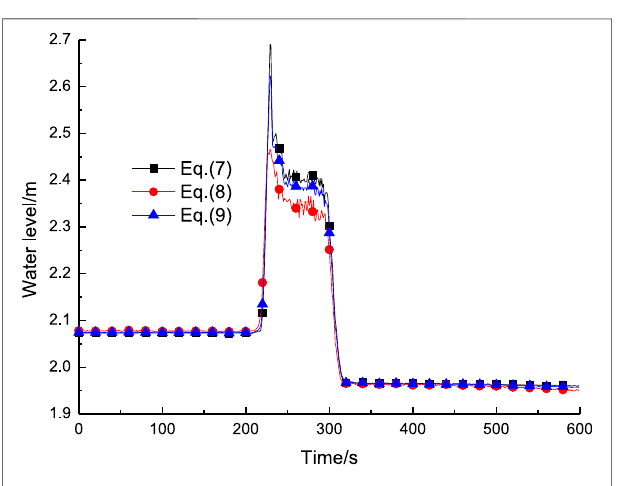
FIGURE 10 | Water levels of slow